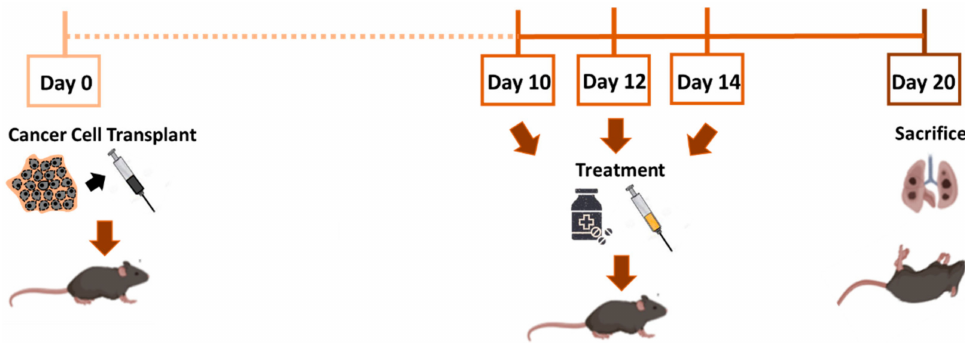
Figure 3. Schematic representation of the metastasis growth inhibition experiment.